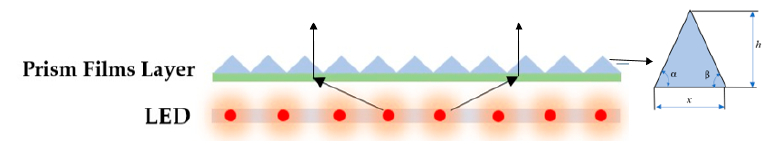
Figure 3. The structure of the proposed automotive rear light.